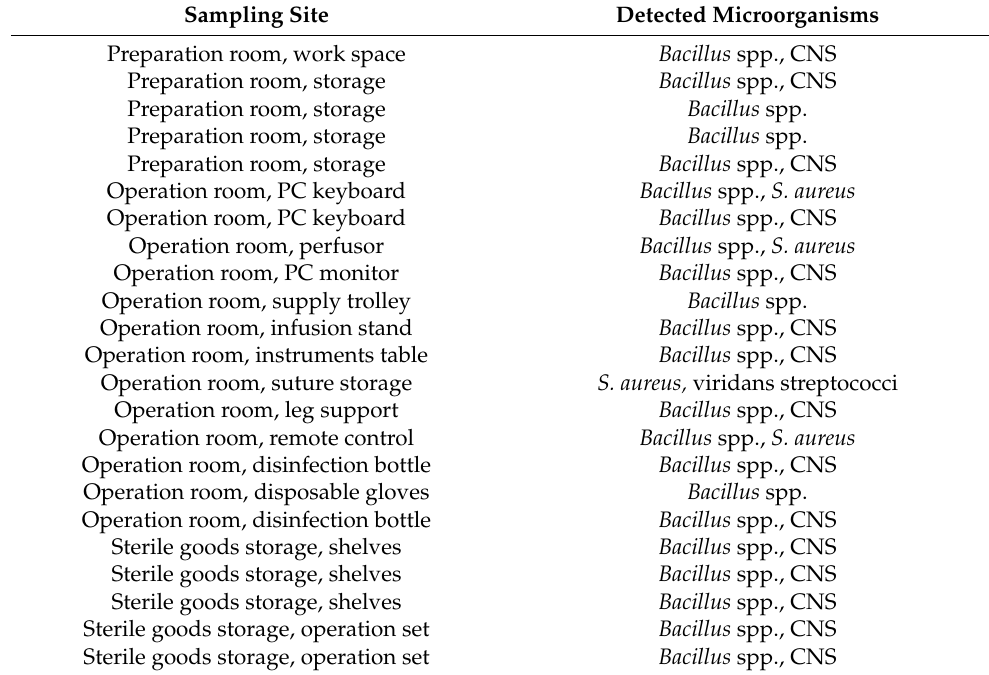
Table 3. Environmental swab